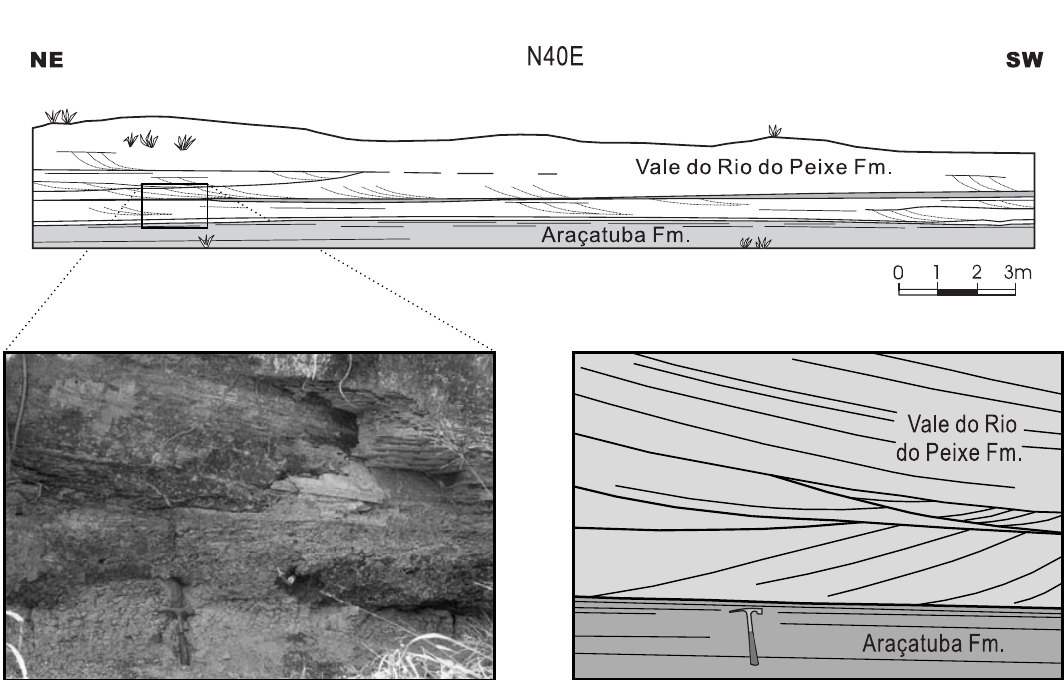
Fig. 6 – Contac between Araçatuba and Vale do Rio do Peixe formations: evidence of the Araçatuba paleoswamp silting by eolian dunes. Location: SP 425 highway, around km 329, close to Clementina (UTM:556841/7613565).